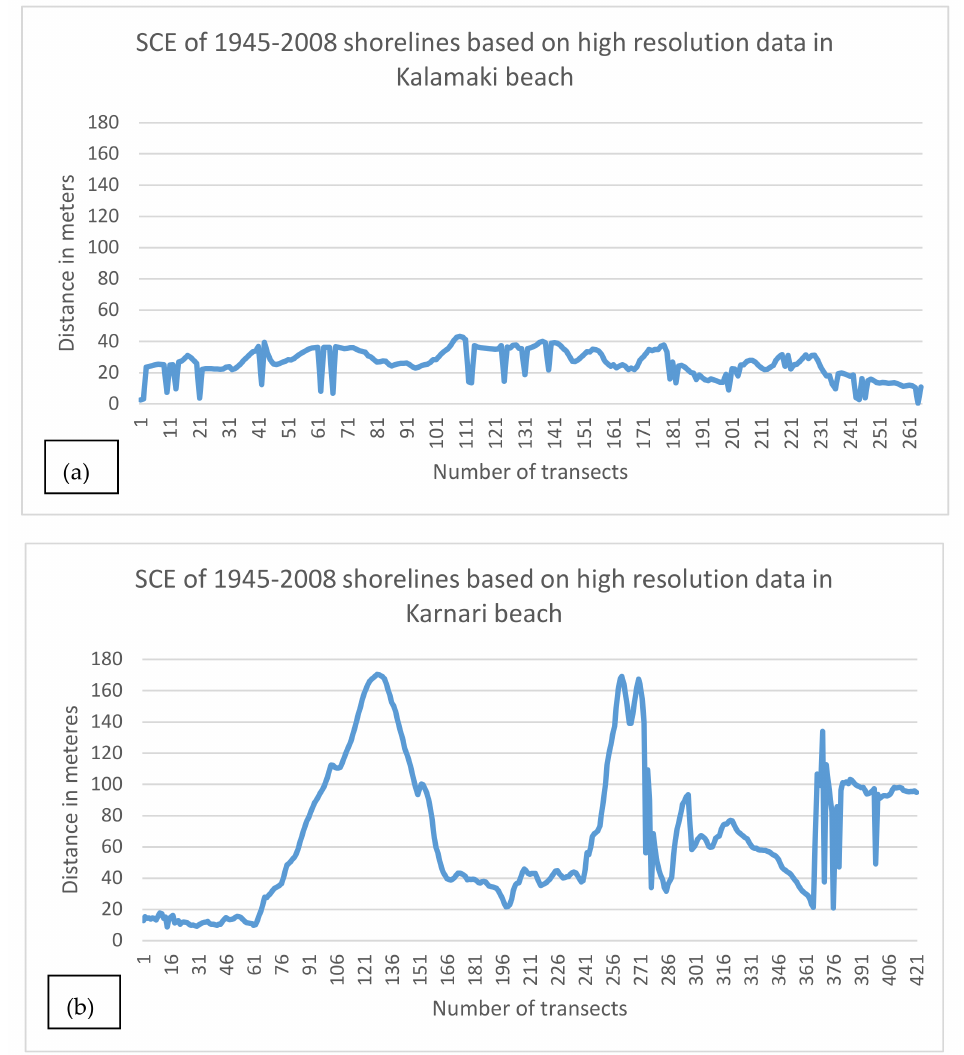
Figure 6. Shoreline change envelope (SCE) rates of 1945–2008 shorelines based on high-resolution data for ( a ) the Kalamaki and ( b ) Karnari